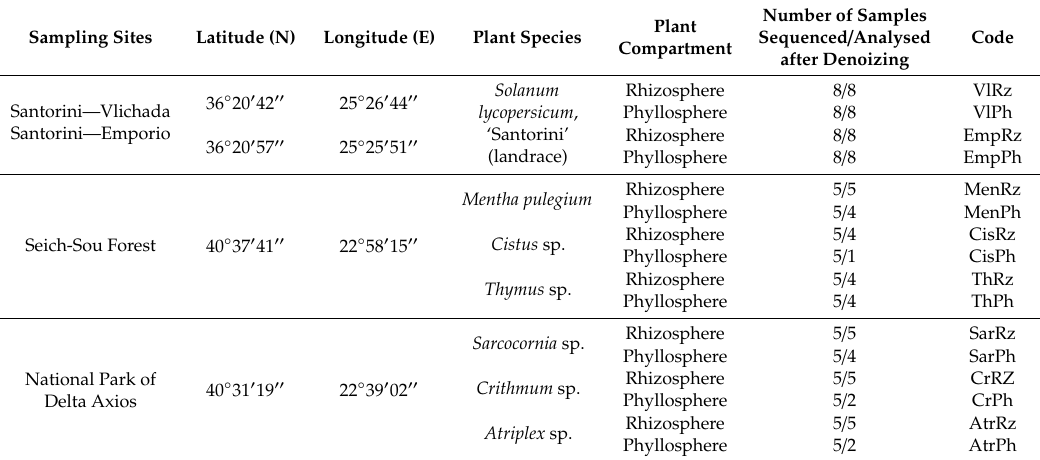
Table 1. Details on the sampling procedure: Sampling sites, location, plants sampled, part of the plant that samples were collected (phyllosphere or rhizosphere), number of samples left in the dataset after denoizing because of low number of sample reads, and relevant sample code. Sampling Sites Latitude (N) Longitude (E) Plant Species